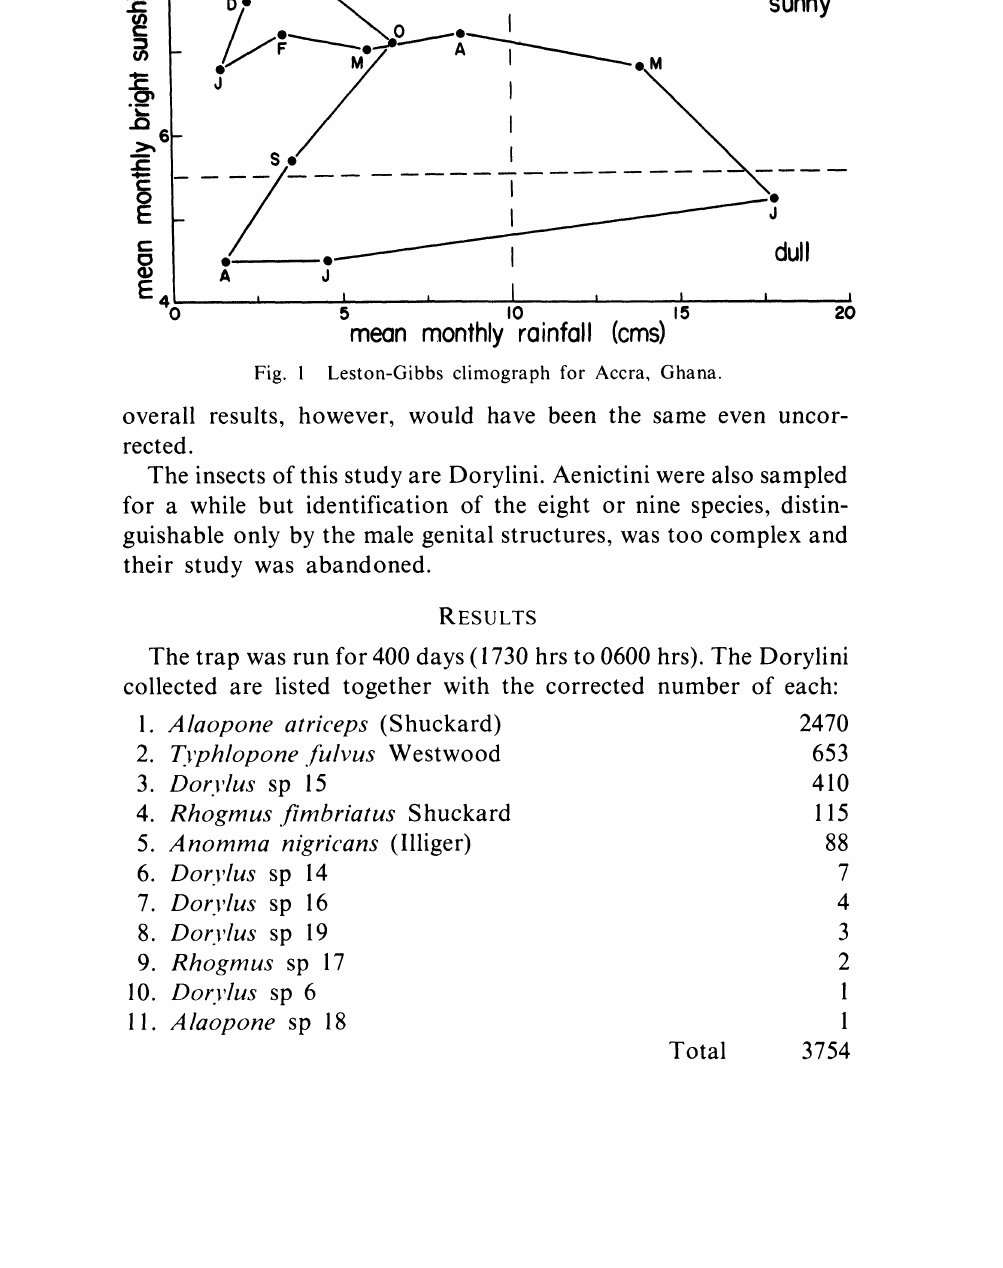
Fig. Leston-Gibbs climograph for Accra,